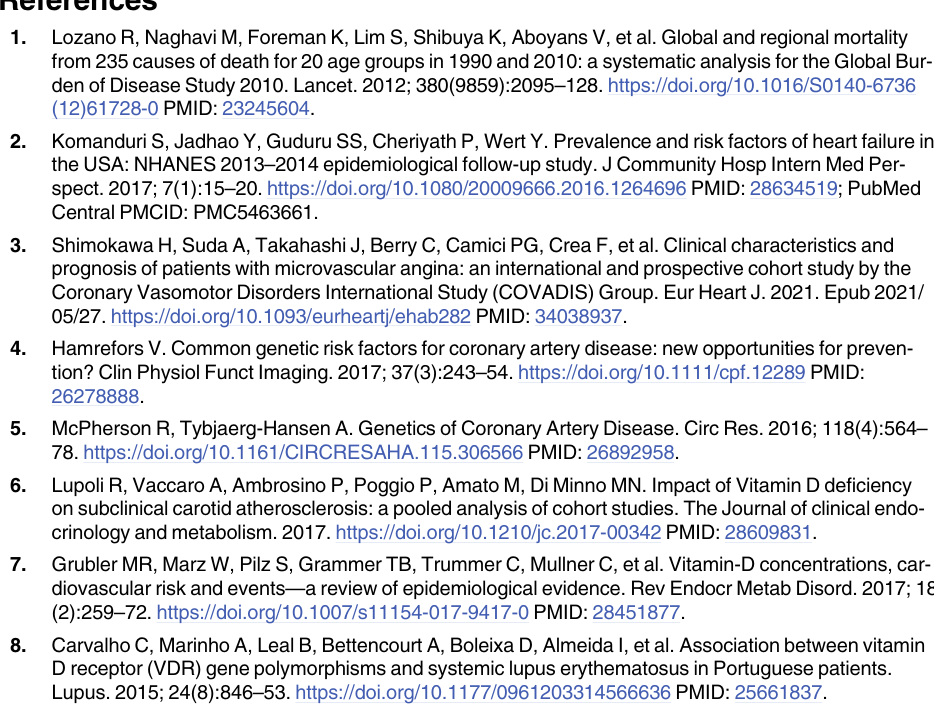
S3 Table. The PRISMA 2009